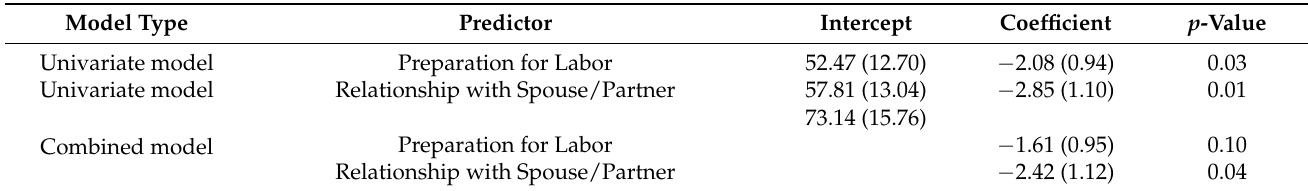
Table 3. Longitudinal relationship of TNF- α /IL-10 and Preparation for Labor and Relationship with Spouse/Partner for the control group. Model